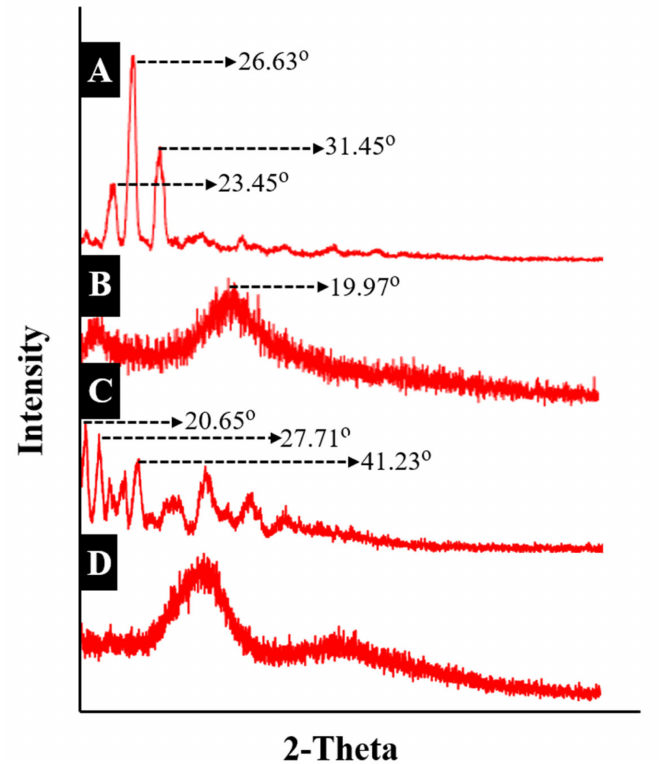
Figure 5. X-ray diffractogram of ( A ) acyclovir, ( B ) tamarind gum, ( C ) β -Cyclodextrin, and ( D ) the developed network